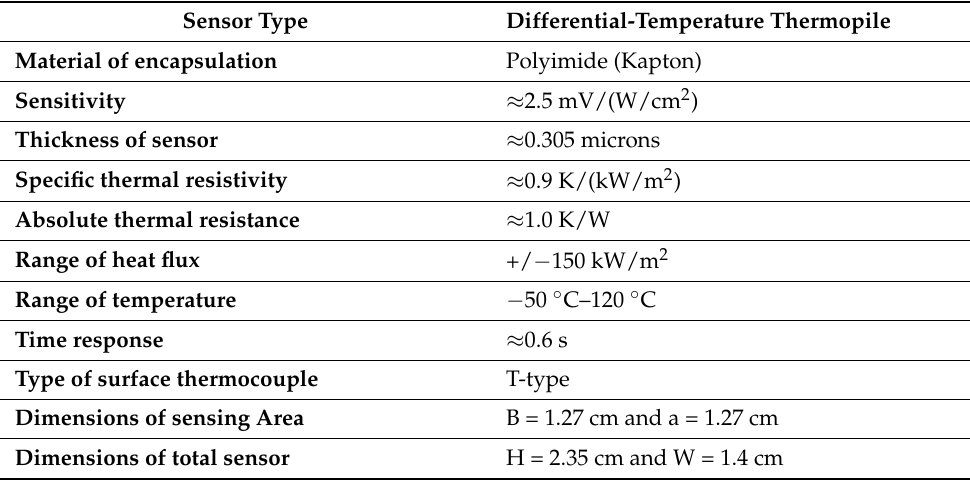
Figure 2. Schematic and photos of triangular and square tube pitch arrangements. Table 1. The specification of the PHFS heat flux